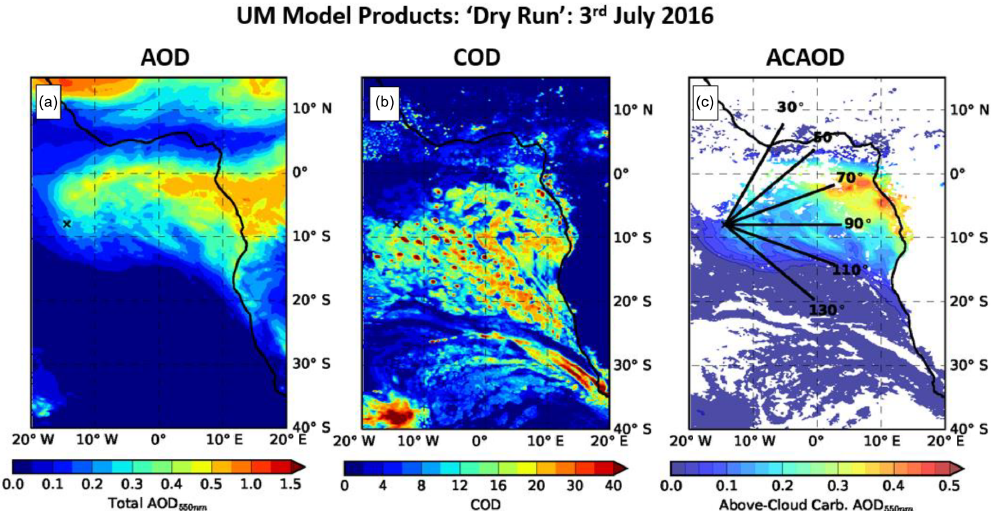
Figure 4. Model forecasts with the CLUMP model for a wavelength of 550nm for (a) aerosol optical depth (AOD), (b) cloud optical depth (COD), and (c) above-cloud AOD (ACAOD; white where there is no cloud). The solid lines in (c) indicate transects over which vertical–horizontal distribution maps aerosol, and cloud properties were provided as data products, some of which are provided in Fig.